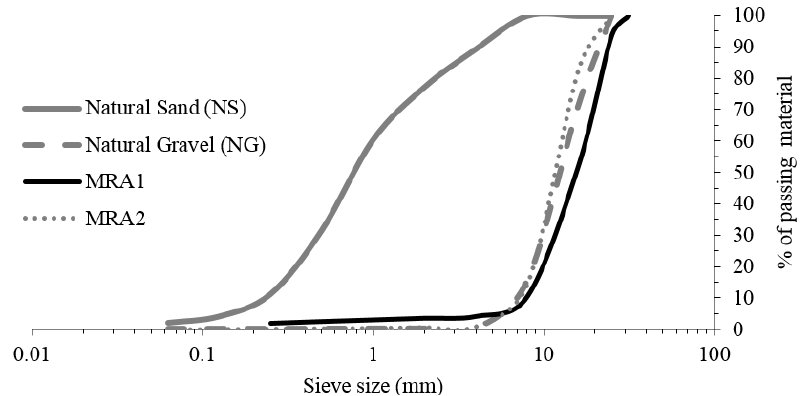
Figure 1. Particle size distribution of aggregates. Mixed recycled aggregates (MRA1 and MRA2).